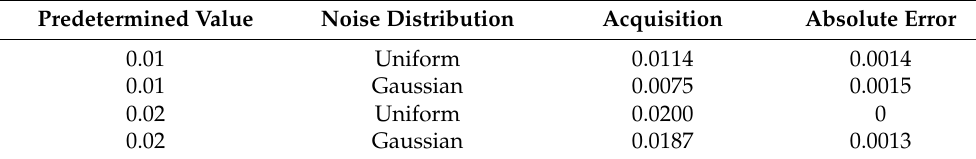
Table 4. The results of leakage coefficient.